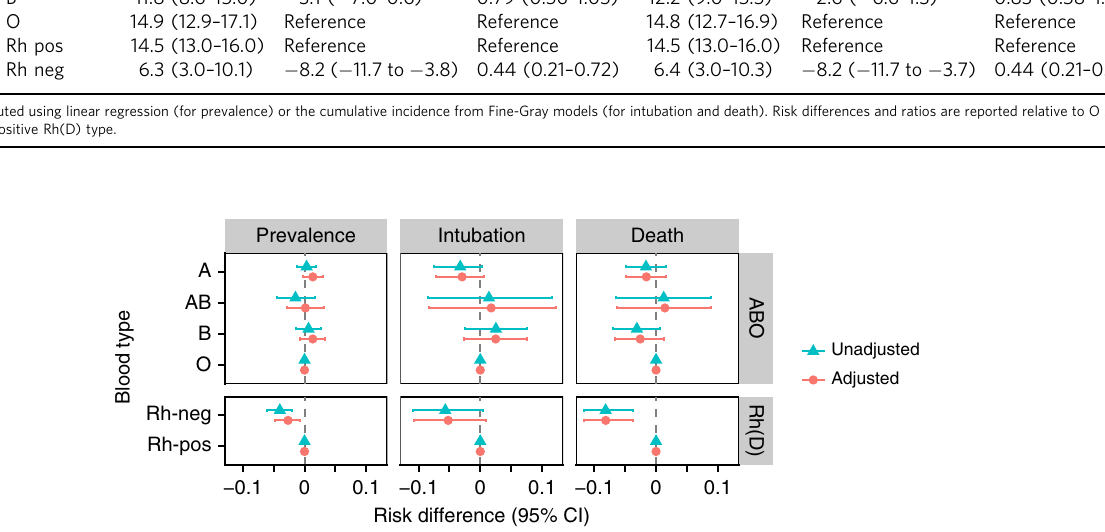
Fig. 1 Estimated risk differences for blood types during the period from March 10 to August 1, 2020. Values represent risk differences for each blood type relative to the reference groups: O for ABO and positive for Rh(D). Prevalence differences were computed using linear regression, while intubation and death were computed using the Fine-Gray model. Estimated differences are represented as points. 95% con fi dence intervals (CI, represented as bars) were computed using the Austin ’ s method with n = 1000 bootstrap iterations. Adjusted models include race and ethnicity as